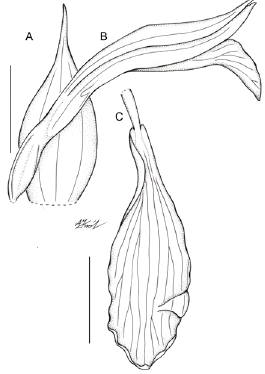
Figure 4. Floral parts of Schiedeella bajaverapacensis: ( A ) floral bract; ( B ) flower—side view; ( C ) Lip. Scale bars—5 mm. Drawn from the holotype by A. Kr ó